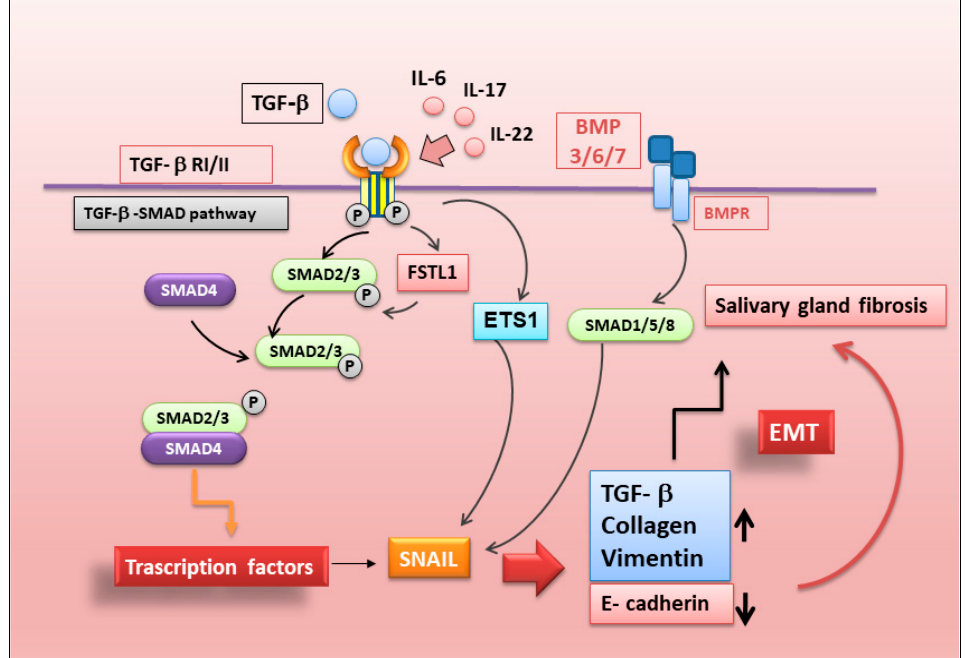
Figure 5. Possible mechanisms of EMT activation in SS. Bone Morphogenetic Protein (BMP); ETS Proto-Oncogene 1, Transcription Factor (ETS); Follistatin-Like Protein 1 (FSTL1); Interleukin-6 (IL-6); Interleukin-17 (IL-17); Interleukin-22 (IL-22); mothers against decapentaplegic homolog 2 (SMAD2), mothers against decapentaplegic homolog 3 (SMAD3); mothers against decapentaplegic homolog 4 (SMAD4); zinc finger protein SNAI (SNAIL); transforming growth factor beta (TGF- β ); transforming growth factor- β type I receptor ( TGF- β RI/I).